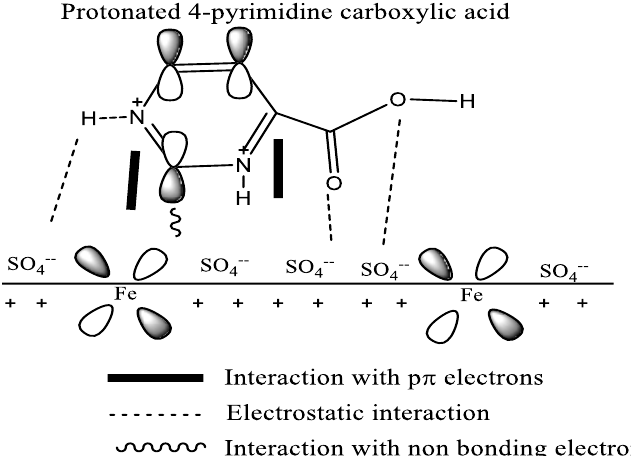
Scheme 4. Mechanism of corrosion inhibition by CNSA molecules in the reference of 4-pyrimidine carboxylic acid.